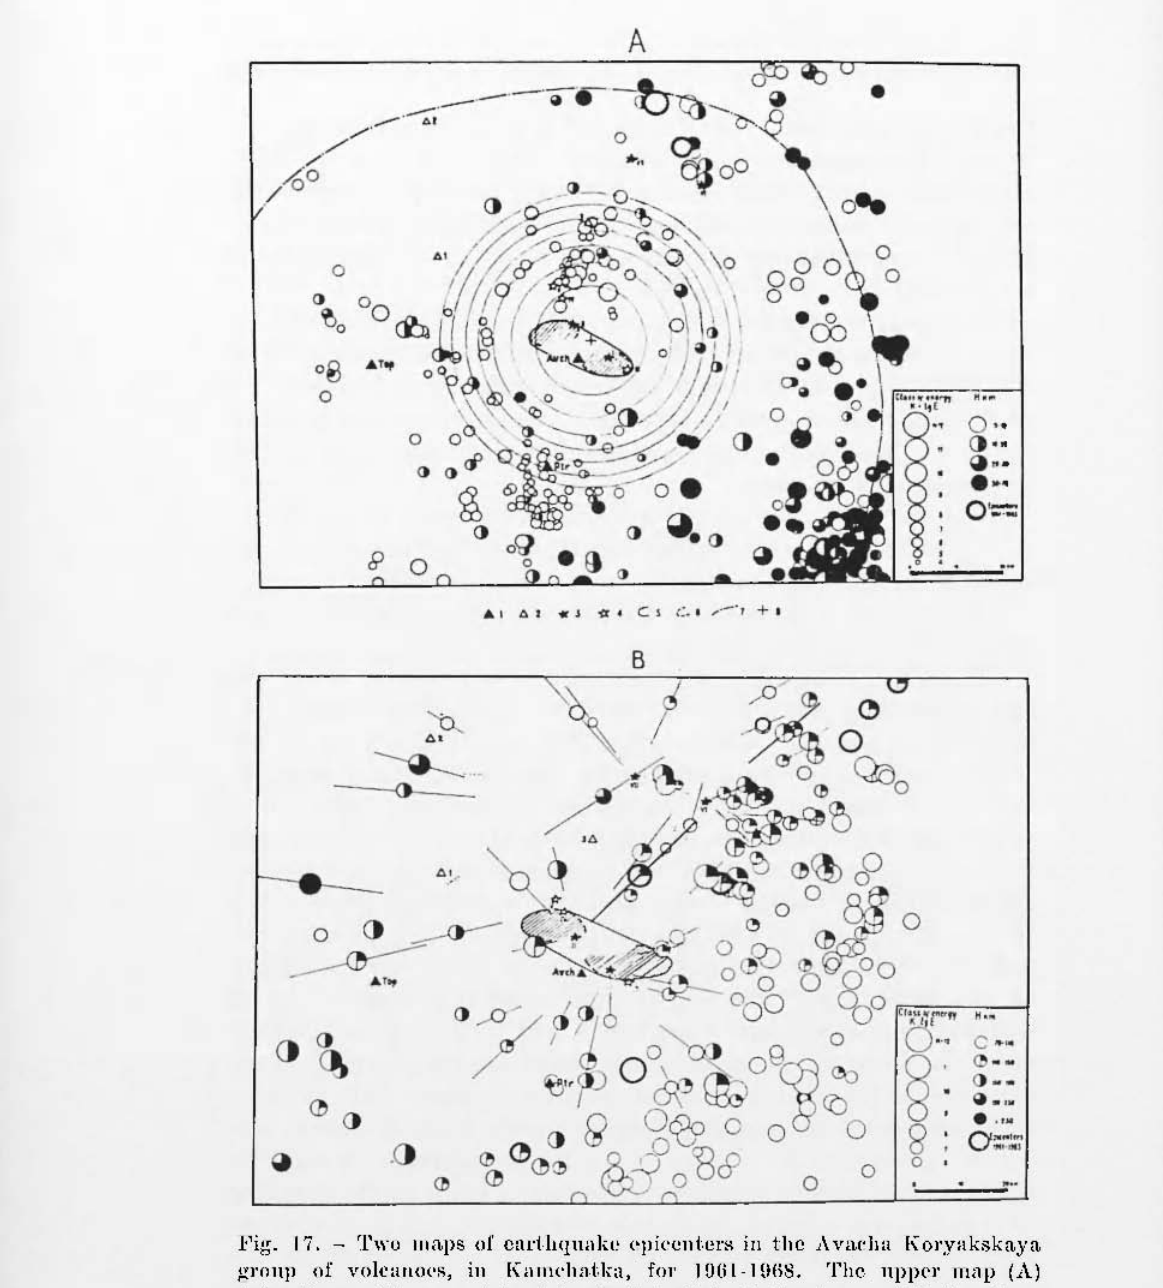
Fig. 17. - 'l'wu IlIaps or clIrtlHl'l1lkt· ('pi('cllt.en; i!l thc Av[tl'ha KOl'yakskaya gl'Oli]! or vo!ca!l()('H, in Kall1chat.ka, for llHil-1UH8. Thc nppel' map